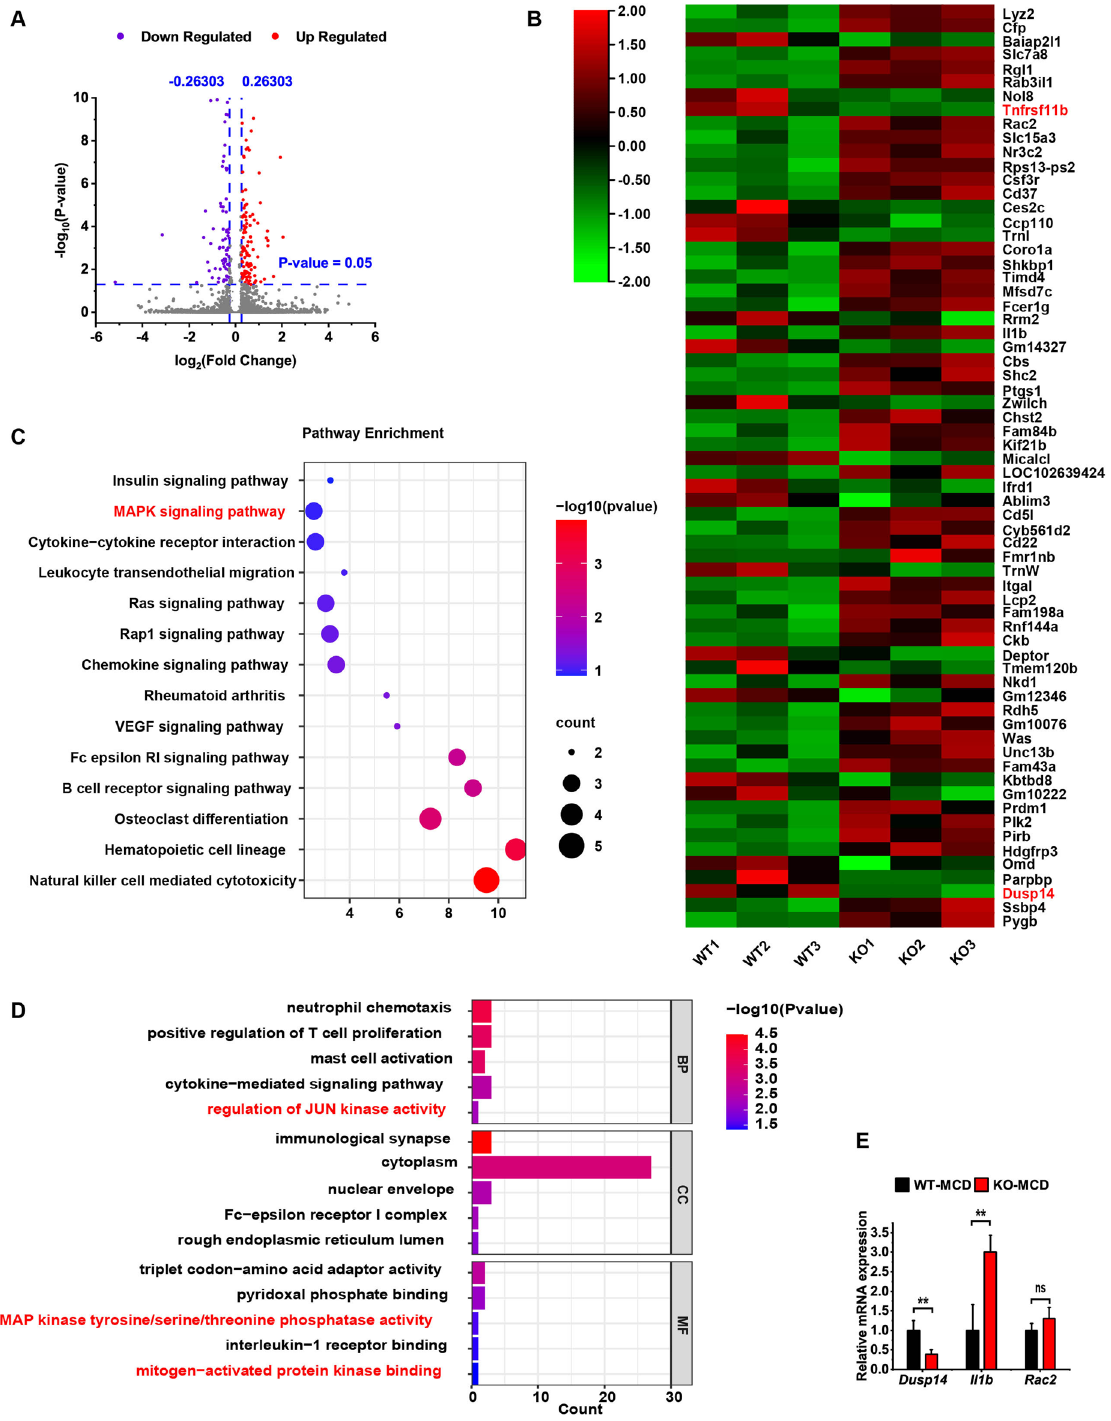
Figure 5. Analysis of the liver transcriptome by second-generation sequencing. ( A ) Volcano map of differentially expressed genes. ( B ) Heatmap of differentially expressed genes. ( C ) Bubble diagram of Kyoto Encyclopedia of Genes and Genomes (KEGG) enrichment analysis. ( D ) Bar chart of gene ontology analysis. ( E ) Quantitative polymerase chain reaction results. Each group at least has 3 samples. The map was plotted using TBtools software 15 (version 1.0986; https:// github. com/ CJ- Chen/ TBtoo ls/ relea ses) and a free online platform for data visualization (http:// www. bioin forma tics. com). Differential gene expression and statistical significance were analyzed using DESeq2 package (http:// www. bioco nduct or. org/). The data in ( E ) are presented as the mean ± SD. ns, no significant difference; **p <